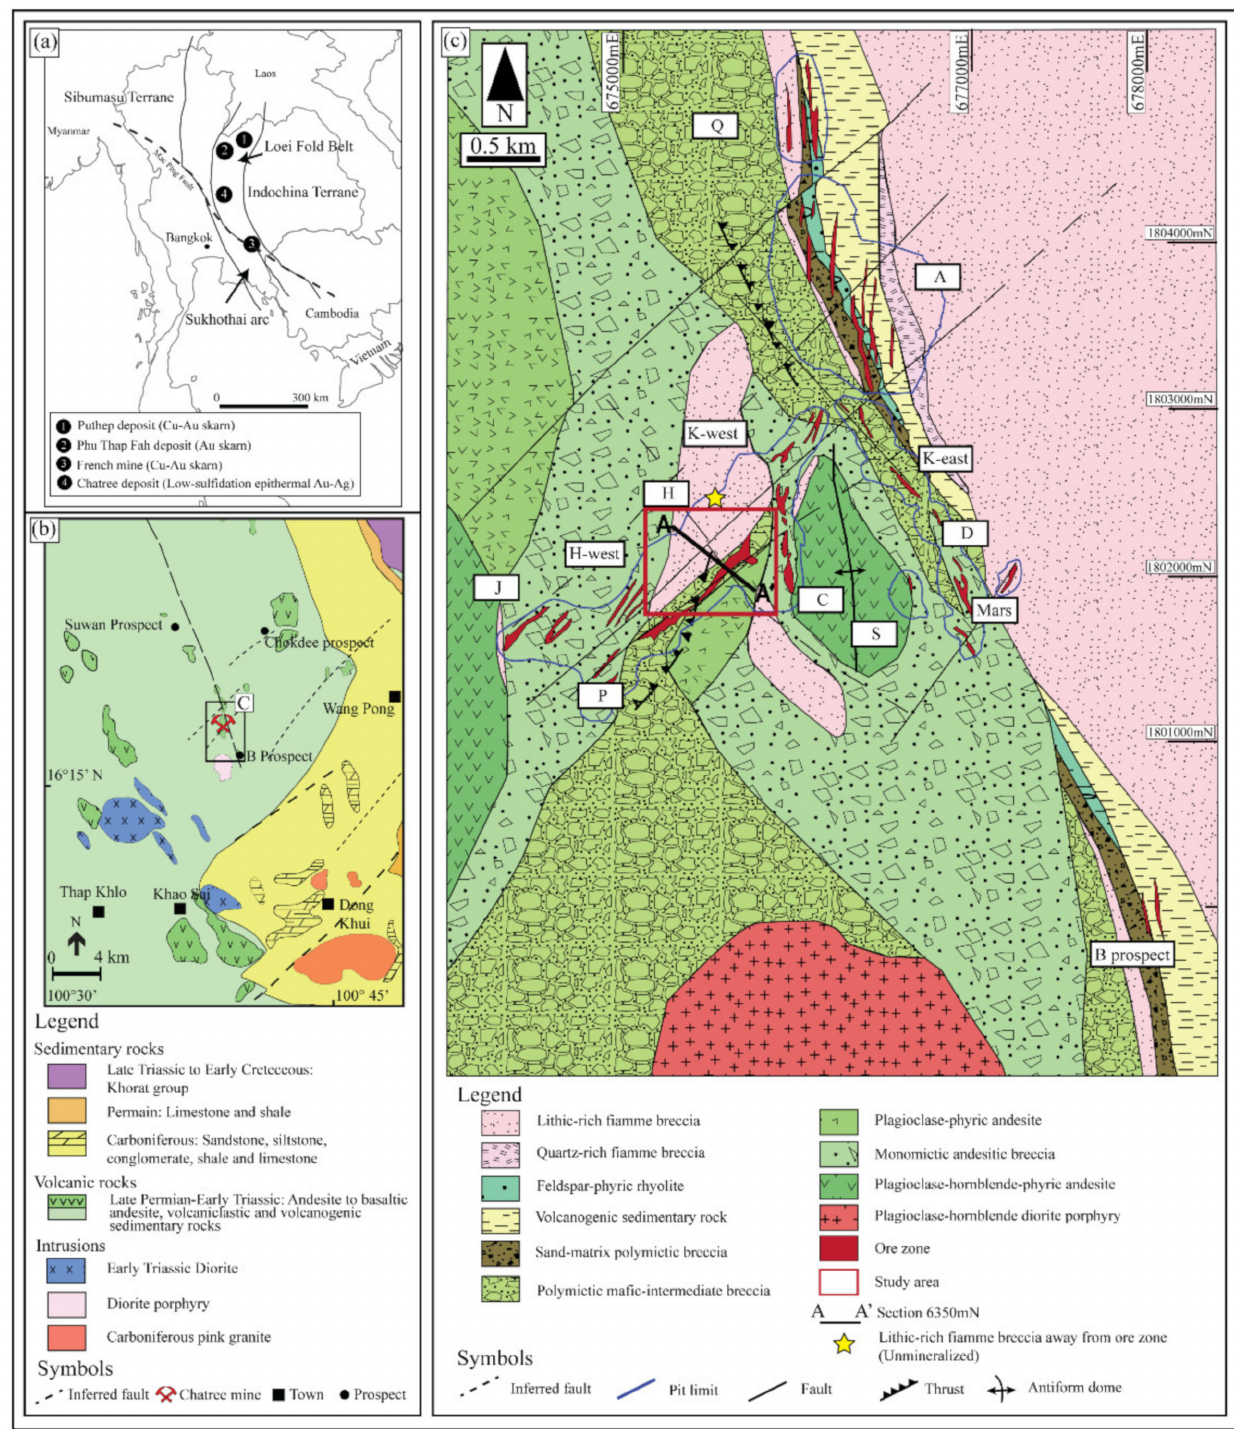
Figure 1. ( a ) Tectonic framework of Thailand and the surrounding regions, with locations of major Cu-Au deposits along the Loei Fold Belt. ( b ) District-scale geology of the Chatree deposit area. ( c ) Geological map of the Chatree deposit and the surrounding areas showing dominant volcanic and volcanogenic sedimentary rocks. The Chatree deposit has several pits, such as Q, A, K-west, K-east, H, C, H-west, J, P, D, S, and Mars pits. Data are modified after Salam [30]. The study focused on section 6350 mN and the lithic-rich fiamme breccia sample (background sample) collected away from the ore zone (yellow